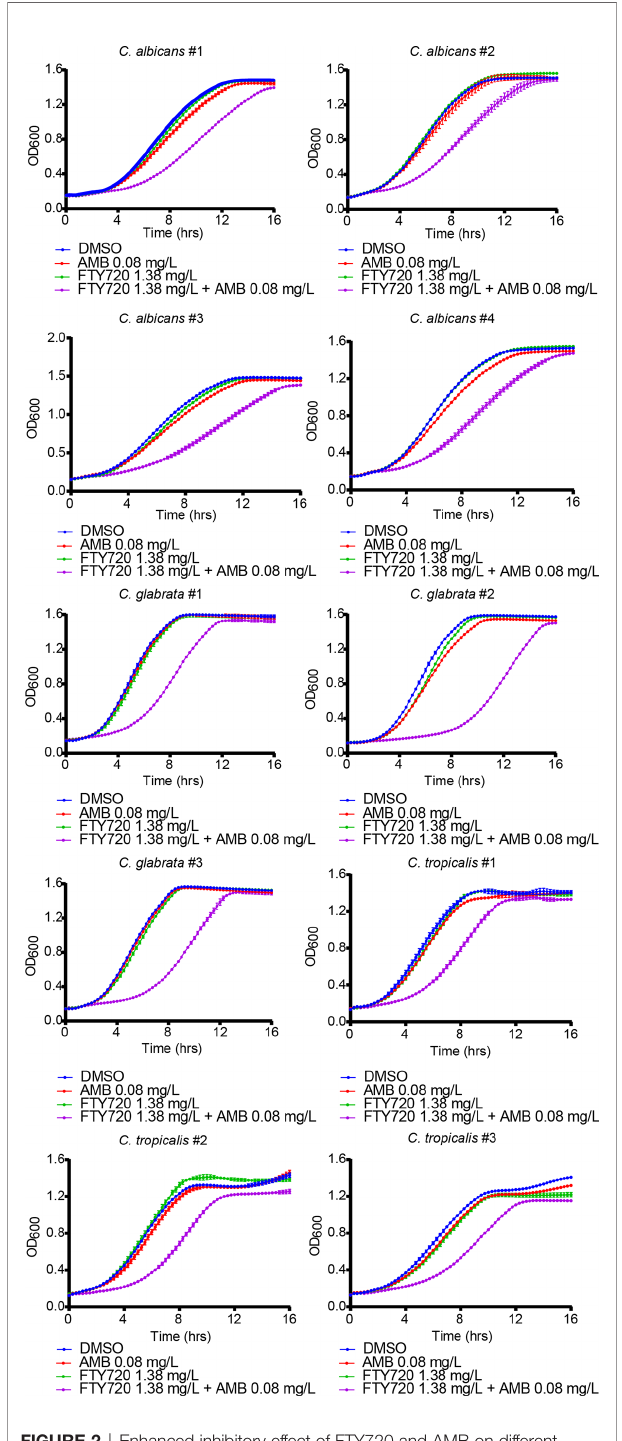
FIGURE 2 | Enhanced inhibitory effect of FTY720 and AMB on different Candida clinical isolates. The OD 600 was obtained every 15 min in a BioTek plate reader for 16 hours. Results are represented by the mean ± SD of three biological